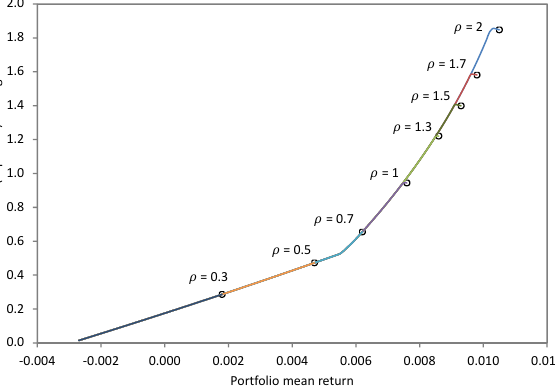
Figure 8. Model-realized expected leverage on target mean m as ρ is increased.